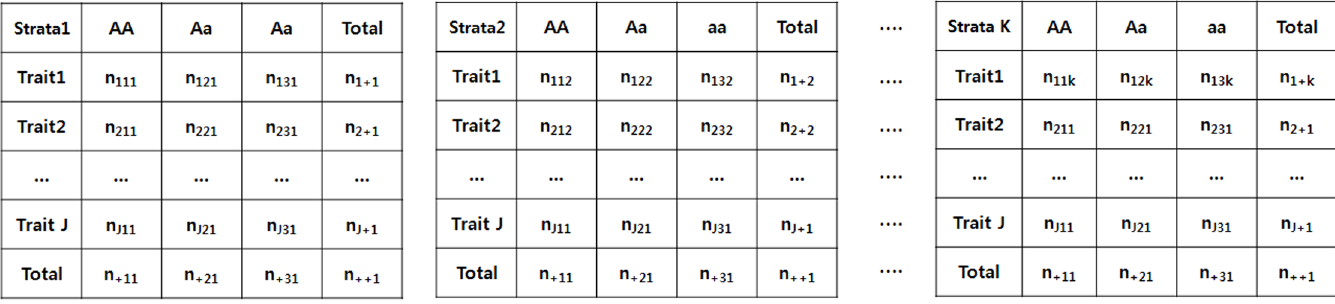
Fig 1. Contingency table for CMH test between trait and p SNPs. This test can be represented as H 0 : Y ? SNP|(number of p -1 SNPs). “ A ” and “ a ” represent major and minor alleles,